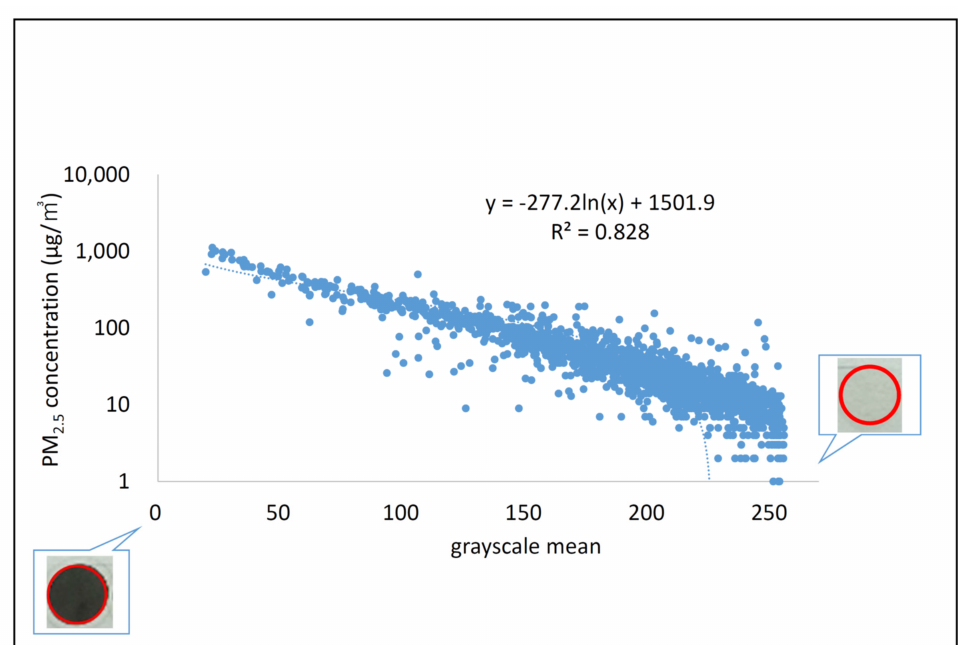
Figure 7. Image J analysis of grayscale mean value and PM 2,5 concentration plot for each sampling spot. The left bottom image in the balloon is a dark-colored PM 2.5 sampling spot that indicates a small number of grayscale mean values, and the right gray-colored spot image of the right balloon image has higher grayscale mean